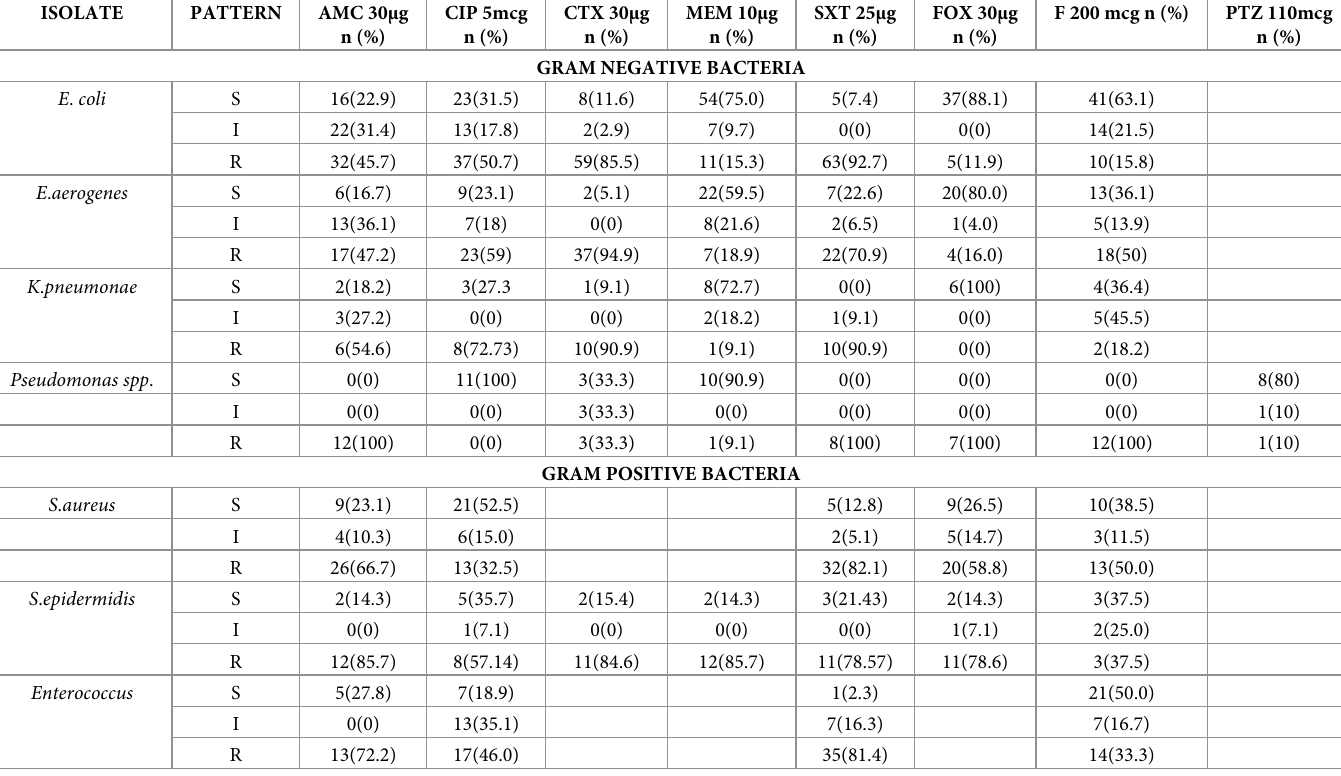
Table 2. Antimicrobial susceptibility patterns of bacterial isolate of urinary catheters from post-partum women. ISOLATE PATTERN